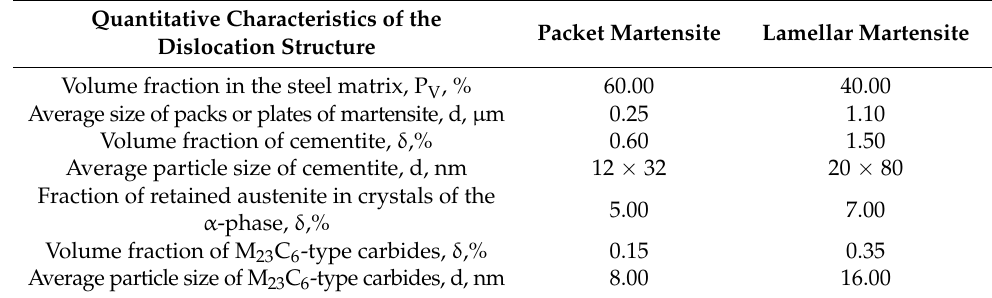
Table 4. Morphological components of the α -phase of 0.34Cr-1Ni-Mo-Fe steel after PEH and quanti- tative characteristics of the dislocation structure in